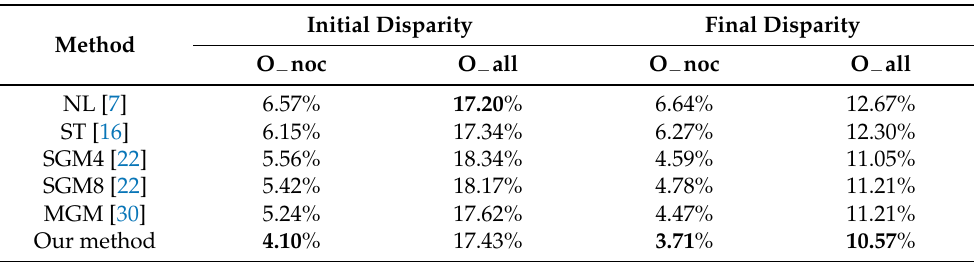
Table 3. Comparison with state-of-the-art non-local cost aggregation approaches on Middlebury dataset [9]. O − all: percentage of erroneous pixels in all region. O − noc: percentage of erroneous pixels in non-occluded region.